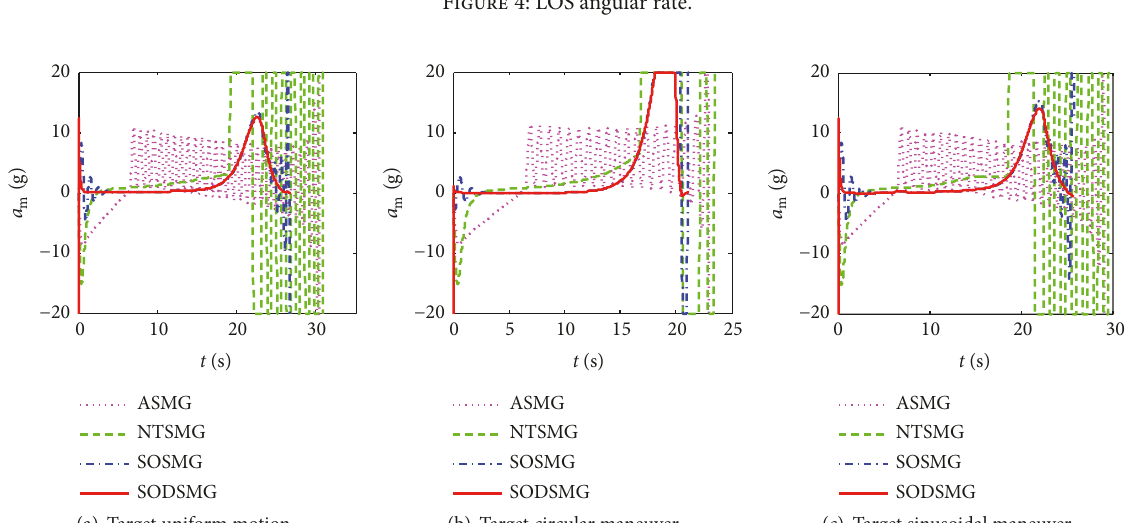
Figure 4: LOS angular rate.